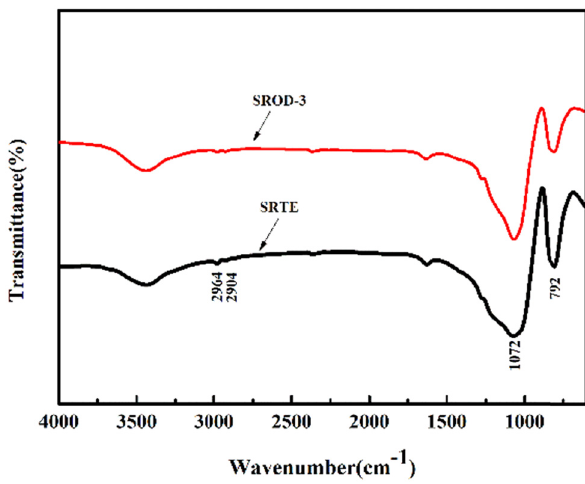
Figure 10: FTIR spectra of degradation residues of SRTE and SROD - 3 samples.